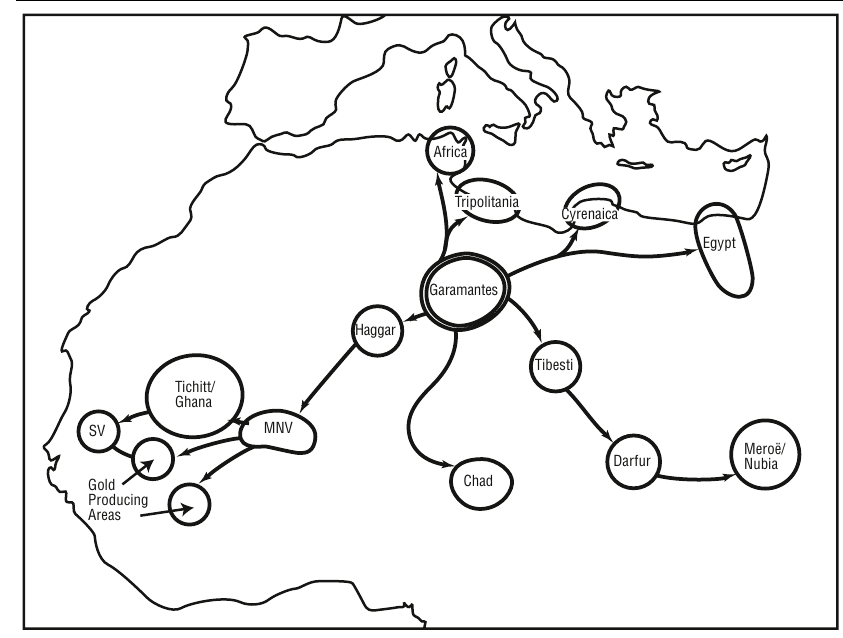
Figure 6 – Saharan & Sudanic Interacting Networks (c. 6t c. BC–c. 6t c.